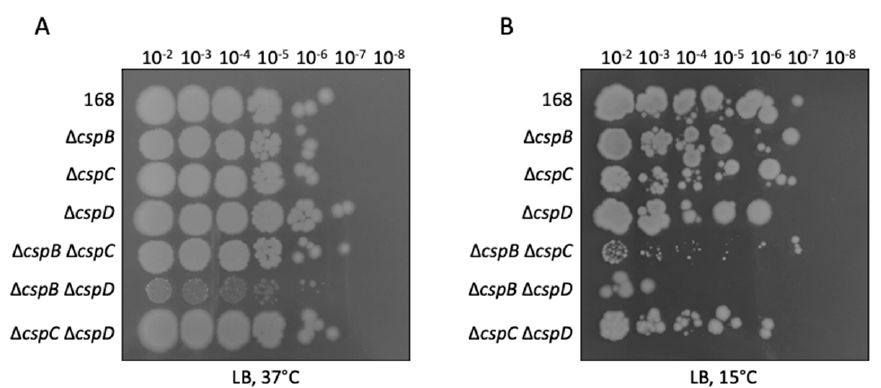
Figure 1. Growth of csp knockout mutants. The wild-type strain B. subtilis 168 and the csp mutants GP1968 ( ∆ cspB ), GP1969 ( ∆ cspC ), GP2614 ( ∆ cspD ), GP1970 ( ∆ cspB ∆ cspC ), GP1971 ( ∆ cspB ∆ cspD ), and GP1972 ( ∆ cspC ∆ cspD ) were cultivated on LB-agar ( A ) at 37 °C for one day and ( B ) at 15 °C for 11 days. The results are representative of three biological replicates.